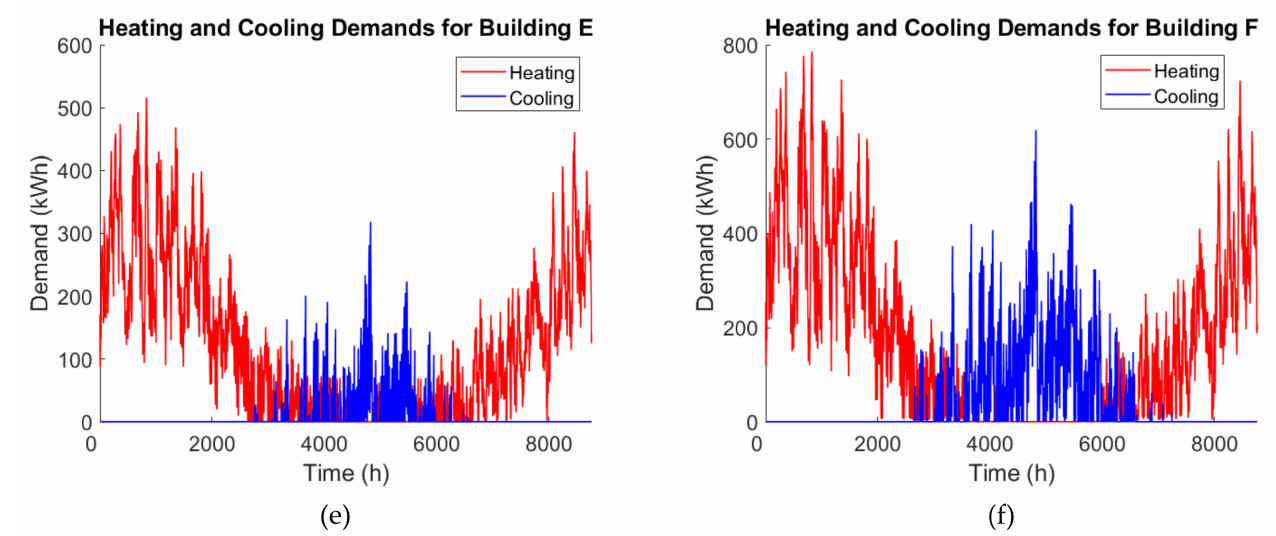
Figure 6. Heating and cooling loads for ( a ) building A; ( b ) building B; ( c ) Building C; ( d ) Building D; ( e ) Building E; ( f ) Building F.